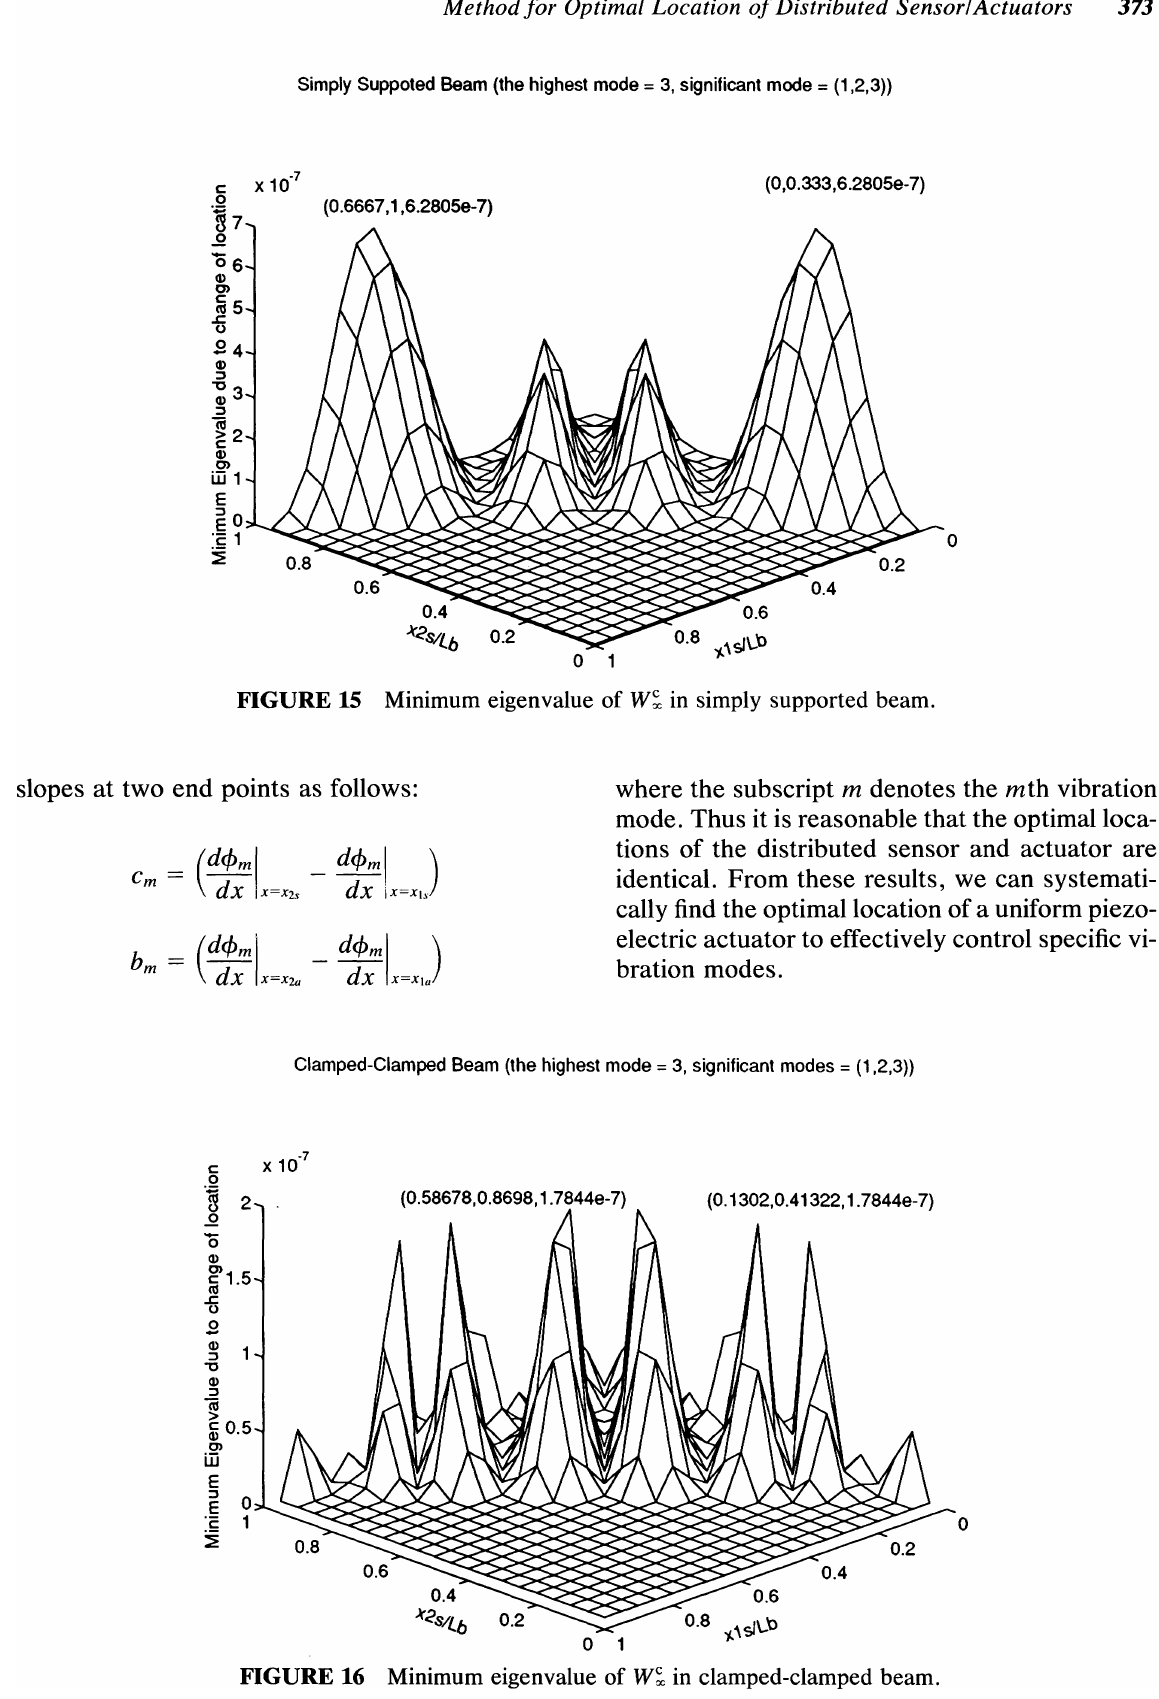
FIGURE 16 Minimum eigenvalue of W~ in clamped-clamped